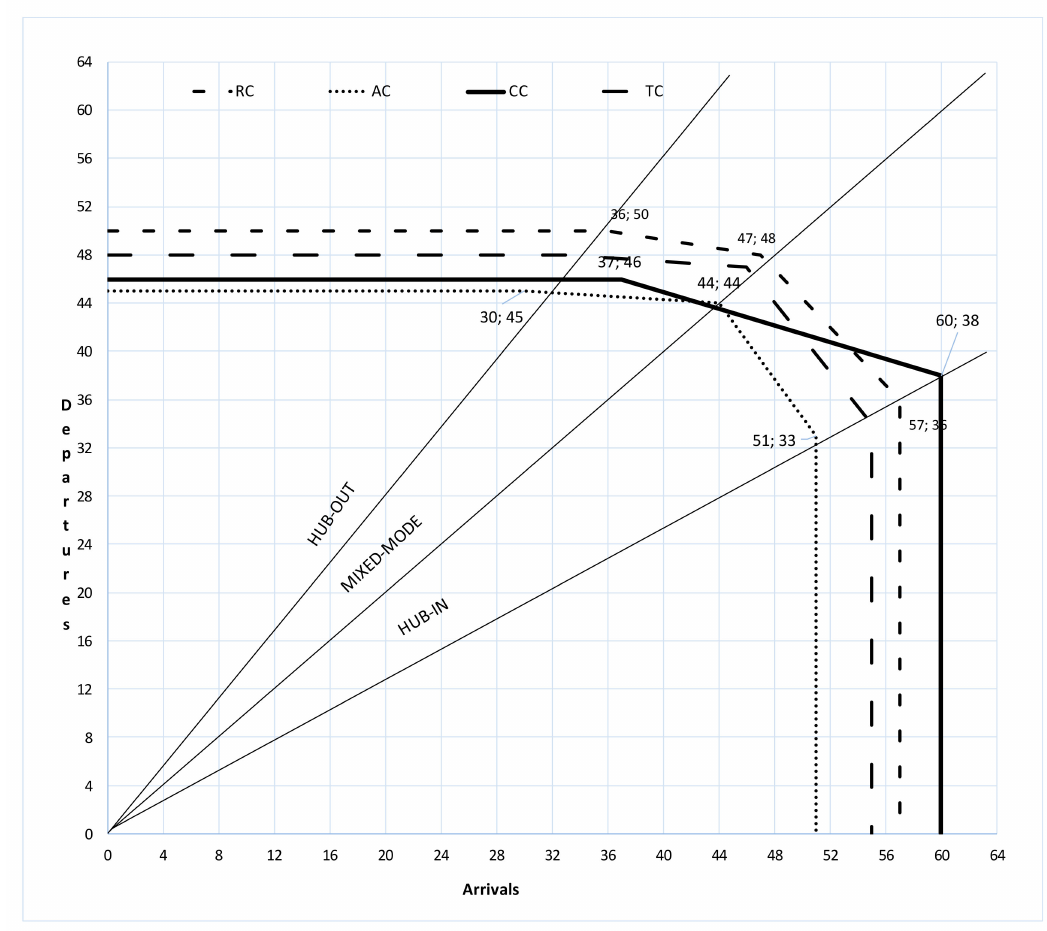
Figure 7. Comparison of runway (RC), current airside (AC), potential airside (TC), and ATC capacity frontiers